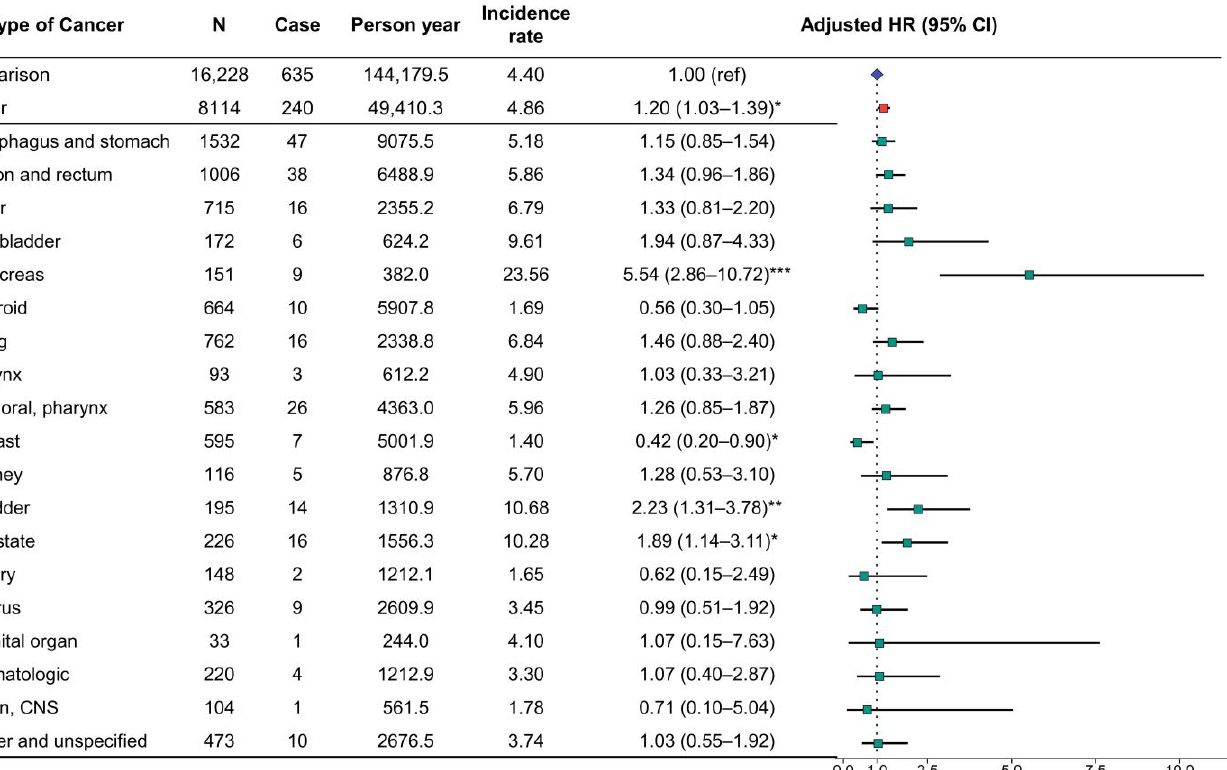
Figure 5. Incidence rate and adjusted hazard ratio for cases of diabetes-associated complications in